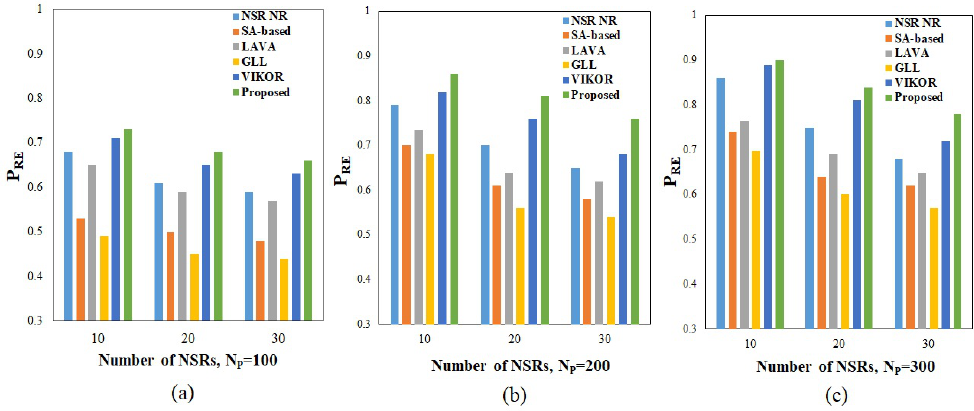
Figure 4. Resource efficiency under ( a ) 100, ( b ) 200, and ( c ) 300 nodes in physical infrastructure. Proposed method performance is compared with existing methods such as NSR-NR [19], SA [20], LAVA [21], GLL [22], VIKOR